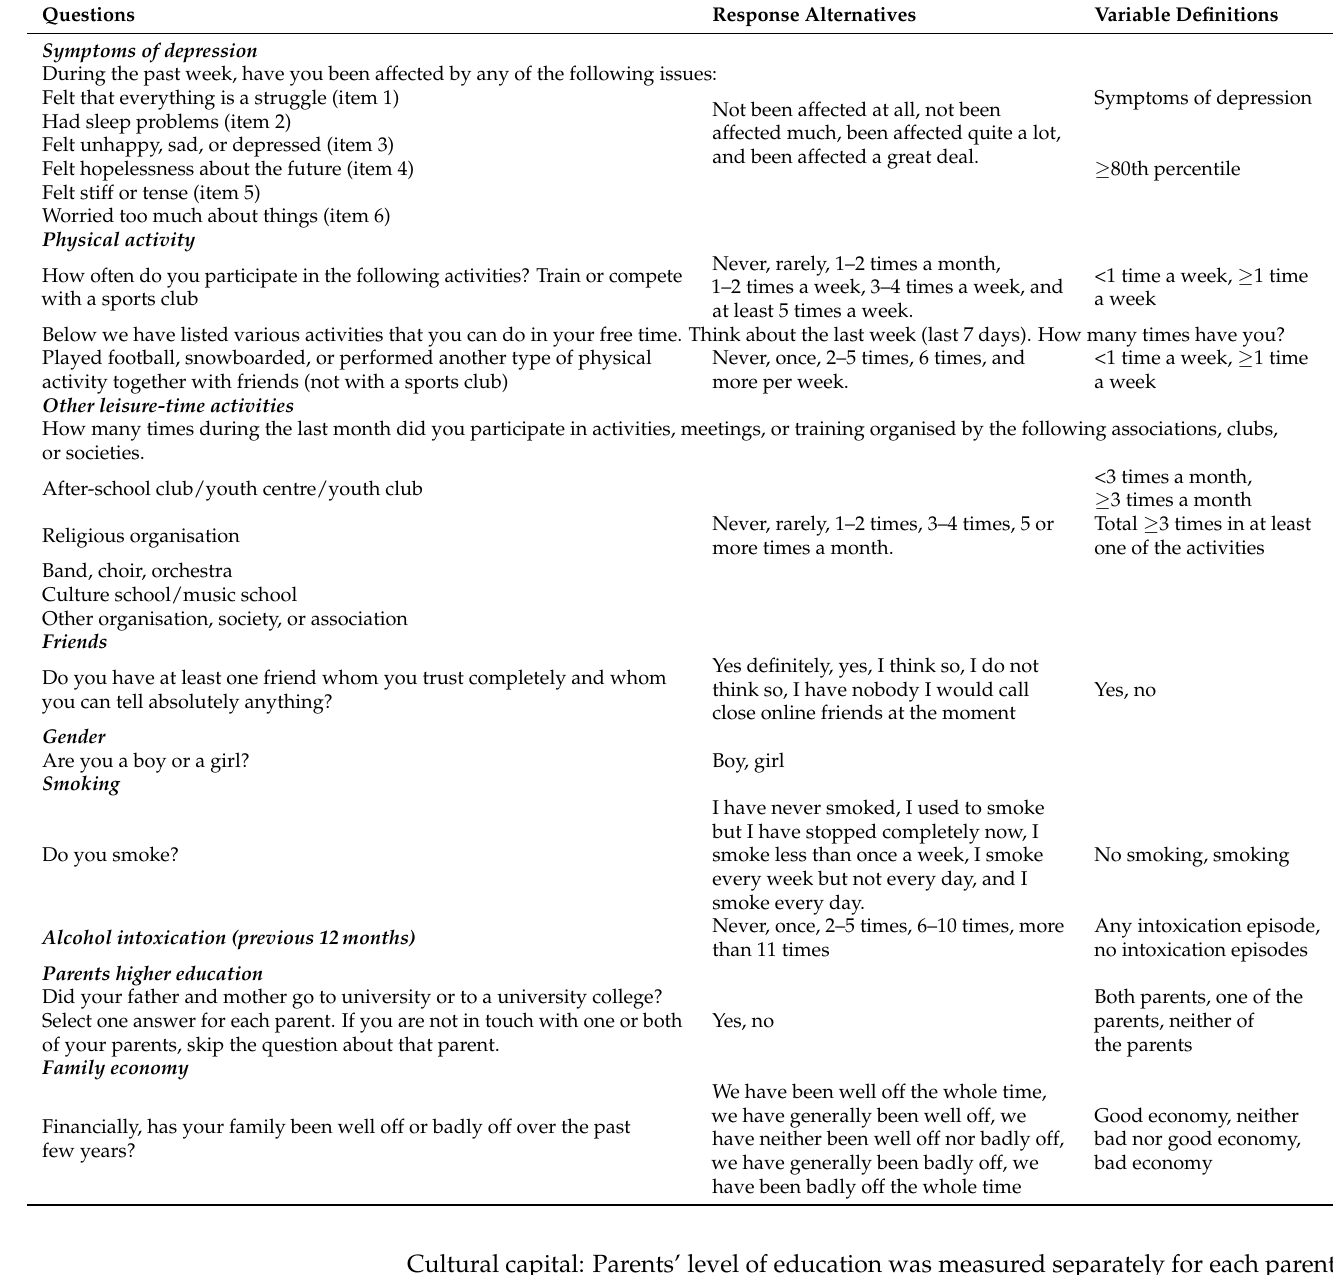
Table 1. Ungdata Survey 2017–2019: questions, response alternatives, and variable